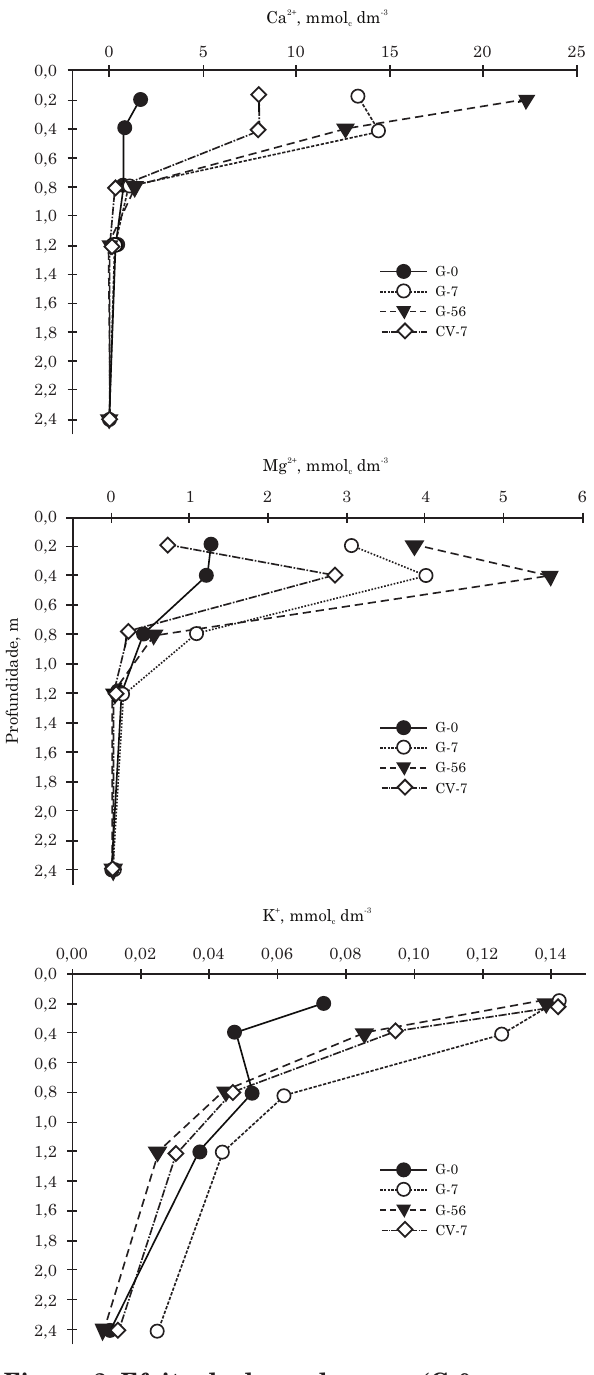
Figura 2. Efeito de doses de gesso (G-0: gesso